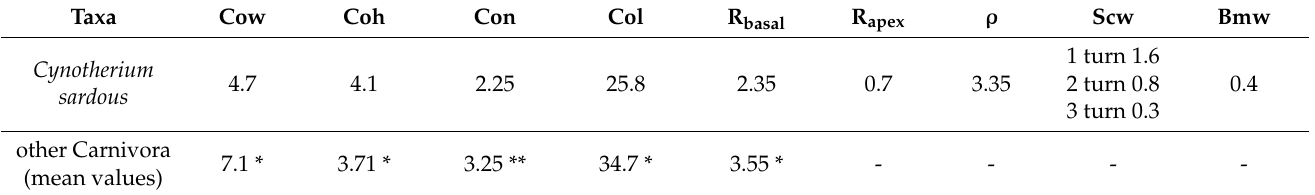
Table 1. Osteometric data of the cochlea of Cynotherium sardous and some mainland carnivore species.